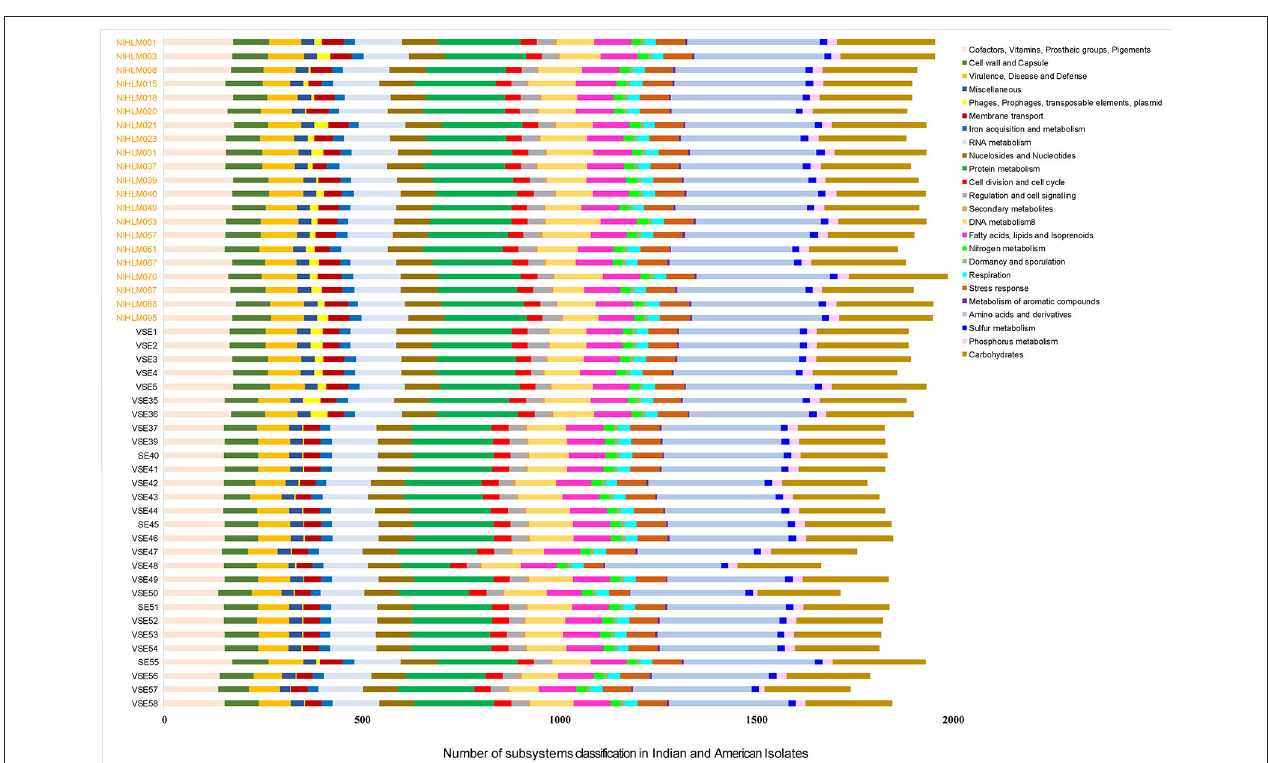
FIGURE 5 | RAST Subsystem distribution analysis of SEI and SEA isolates of lineages, PG1 and PG2.